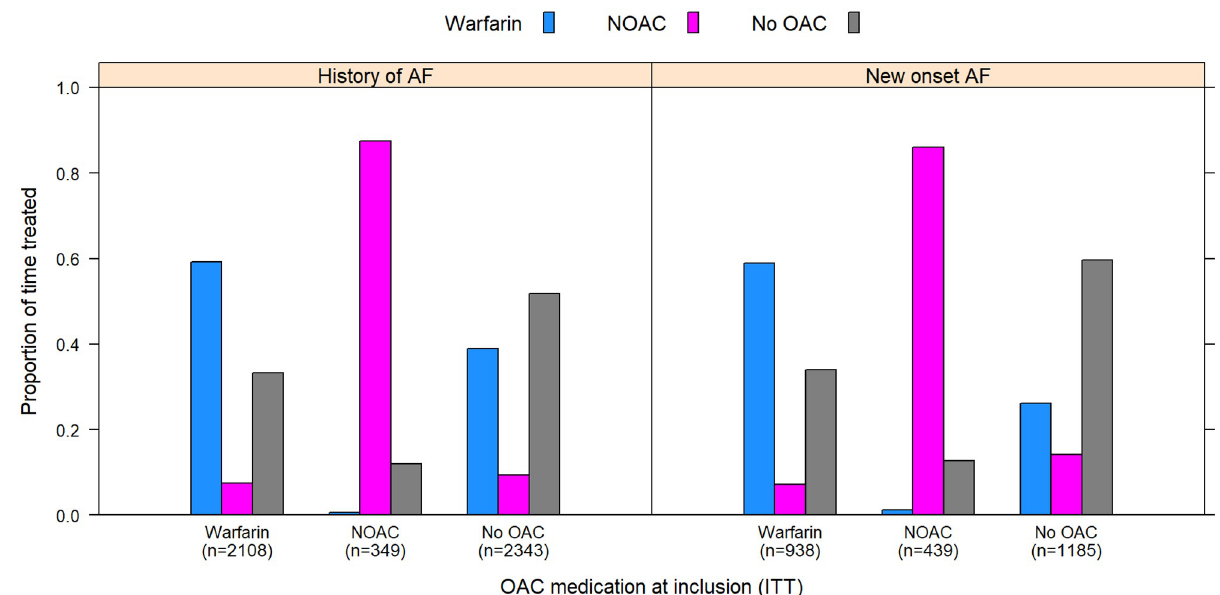
Fig 4. The percent of time during follow up with dispensation of oral anticoagulant treatment. Warfarin (blue), NOAC (purple) and no OAC (grey) in patients with history of atrial fibrillation separated by the OAC dispensation at discharge from valve intervention, and in patients with new-onset atrial fibrillation separated by the OAC dispensation at diagnosis of atrial